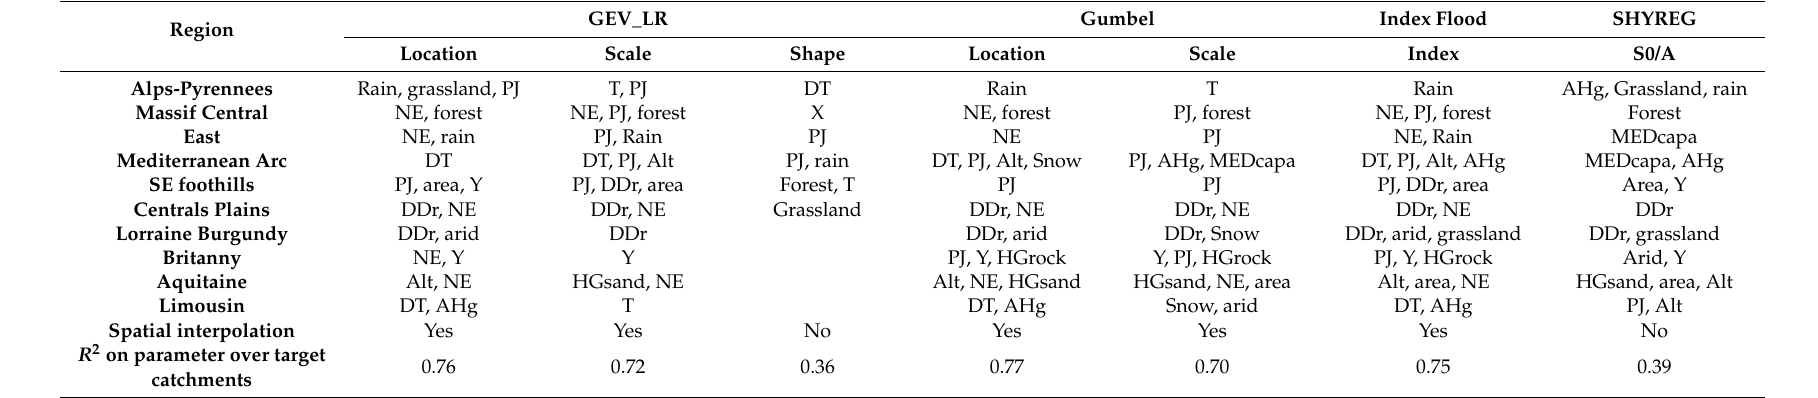
Table 4. Description of the selected regionalisation methods for all FFAs and